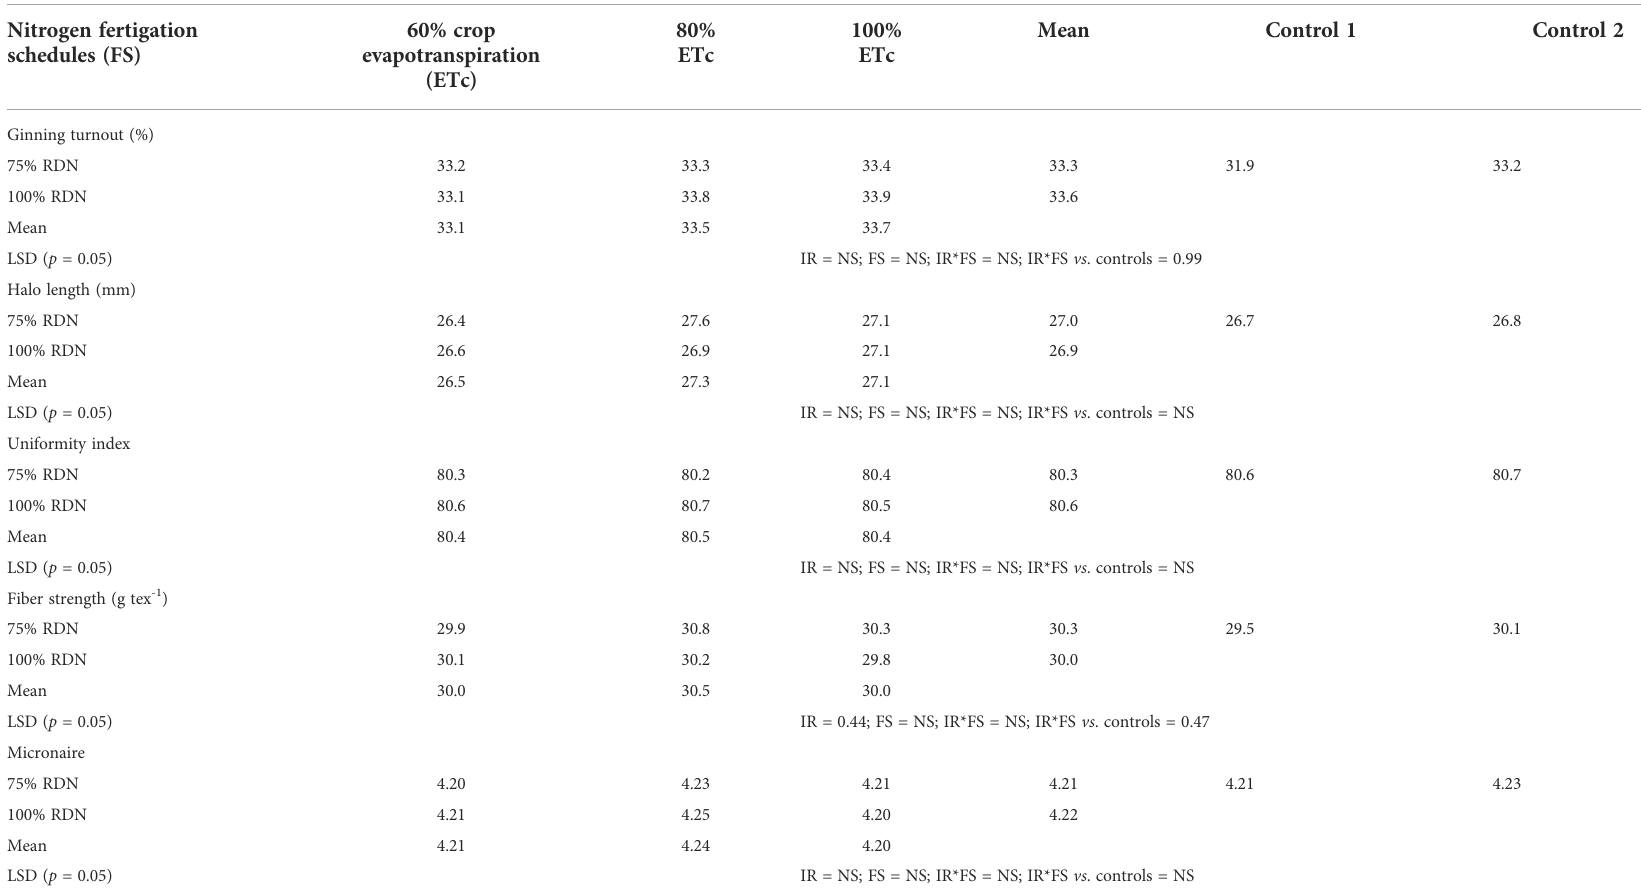
TABLE 9 Effect of various treatments on fi ber quality